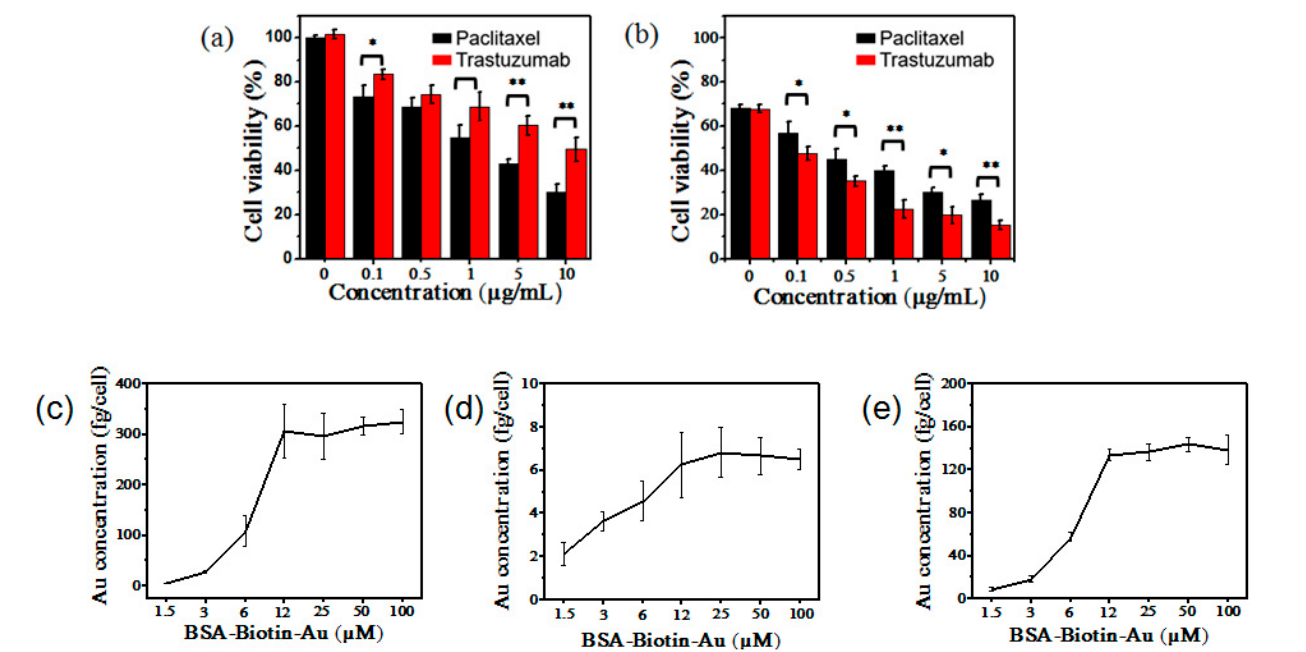
Figure 5. ( a ) Cytotoxicity of paclitaxel and trastuzumab of different concentrations on MDA-MB-231 cells The significant differences between groups were expressed by * p < 0.05, ** p < 0.01. ( b ) Cytotoxicity of paclitaxel and trastuzumab of different concentrations on MDA-MB-231 cells after the stimulation of 0.5 µ g/mL paclitaxel ( c ) ICP-MS of SK cells. ( d ) ICP-MS of MDA-MB-231 cells ( e ) ICP-MS of MDA-MB-231 cells with the stimulation of 0.5 µ g/mL paclitaxel.